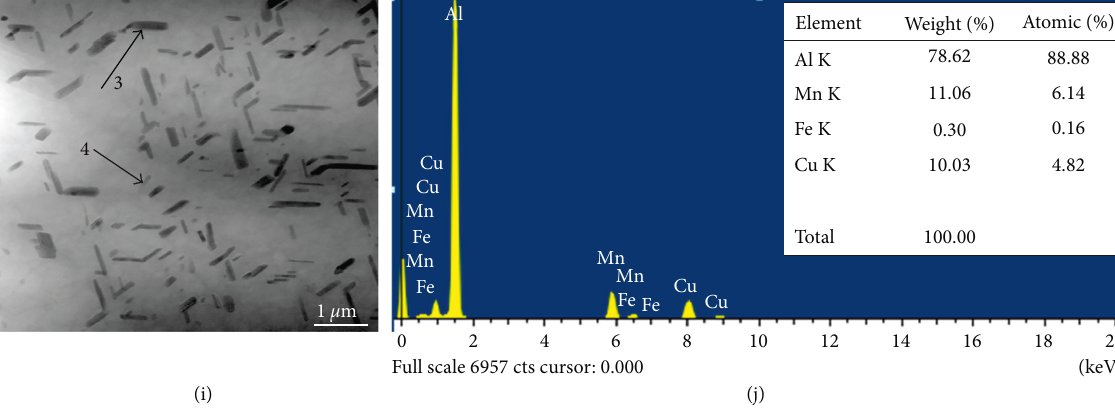
F IGURE 3: Transmission electron micrographs of precipitated particles in A 1 (a), A 2 (e), and A 3 (i) alloys as-solutionized; representative EDS (b) and SAD (c) results of the T Mn phase in the A1 alloy; EDS (d) and SAD (g) results of the AlCu 3 Mn 2 phase and EDS (f) of the T Mn phase in the A2 alloy, respectively, marked by Arrows 1 and 2 in (e); EDS results (h, j) of the particles AlCu 3 Mn 2 and T Mn in the A3 alloy, respectively, marked by Arrows 3 and 4 in